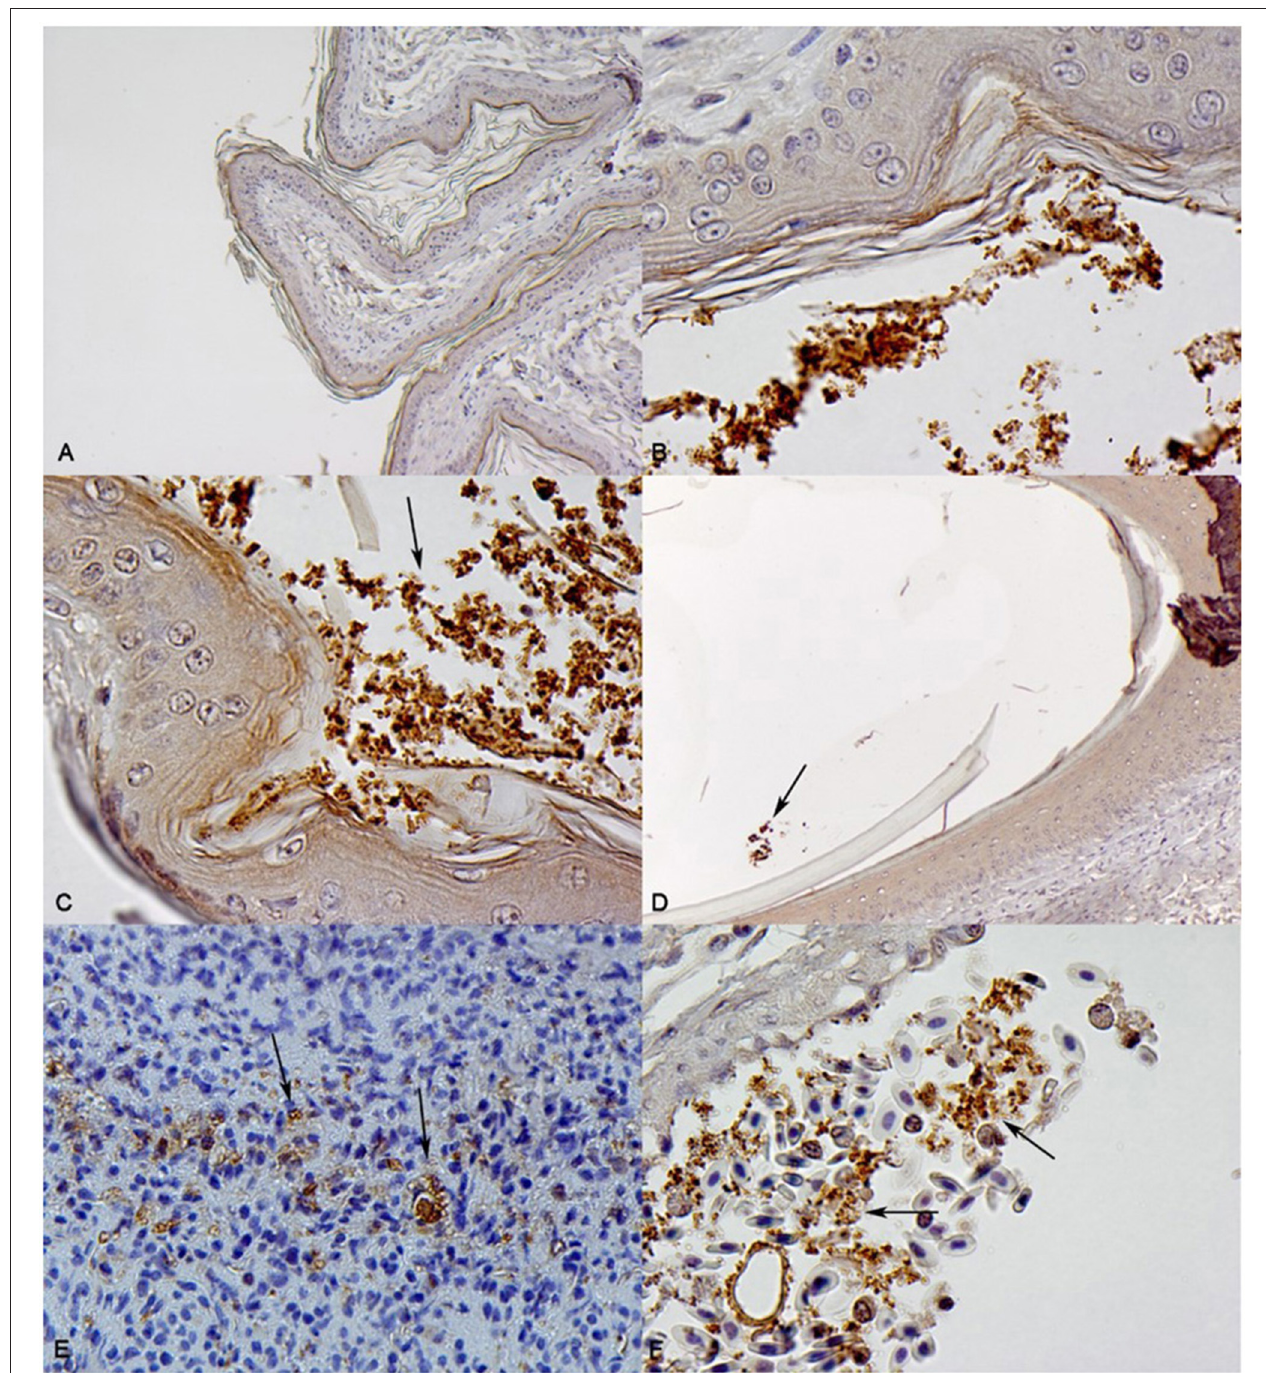
FIGURE 4 | Immunohistochemical localization of Salmonella Heidelberg in skin samples from 11-weeks-old turkeys orally inoculated with S. Heidelberg- lux strains at day of age. (A) Sham-inoculated group, integument and epidermal keratin. Absence of Salmonella O serogroup B-positive bacteria (B) Salmonella O serogroup B-positive bacteria cells in clusters on epidermal keratin. (C) Salmonella O serogroup B-positive bacteria cells in clusters on epidermal keratin and within a fold in the skin (arrow). (D) Salmonella O serogroup B-positive bacteria cells within a feather follicle (arrow). (E) Salmonella O serogroup B-positive bacteria (arrows) within serocellular crust (scab) of an ulcerated skin sample. (F) Salmonella O serogroup B-positive bacteria cells within a blood vessel, free or in cytoplasm of monocyte-like cells (arrows).